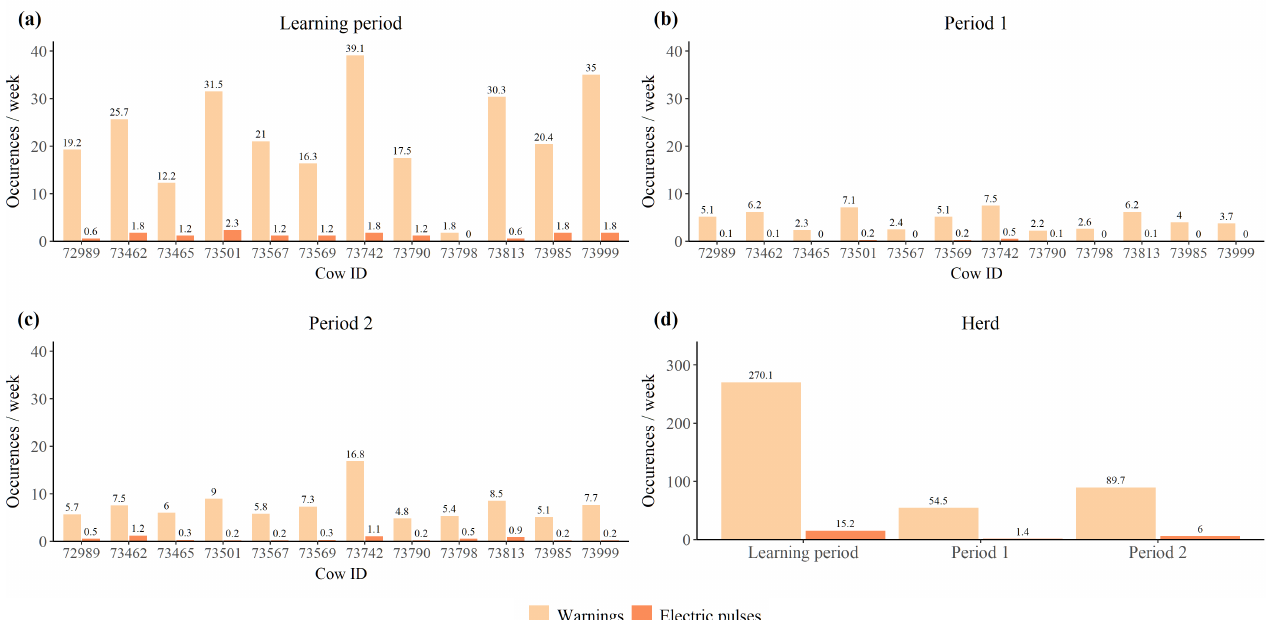
Figure A10. Average number of auditory warnings and electric impulses received per week by ( a ) each individual in the learning period , ( b ) each individual in period 1 , ( c ) each individual in period 2 , and ( d ) the entire herd during each of the three periods. Excluding days where a social panic reaction occurred.